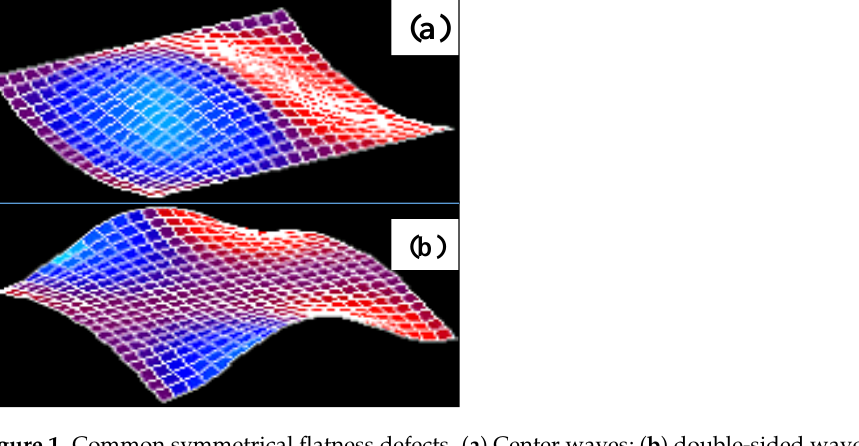
Figure 1. Common symmetrical flatness defects. ( a ) Center waves; ( b ) double-sided waves.